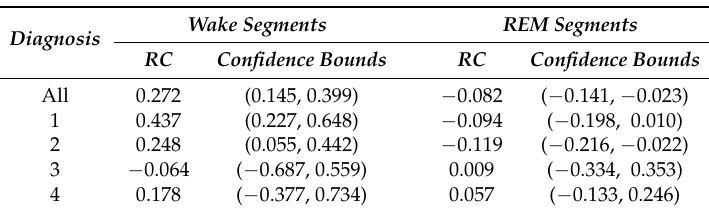
Table 5. The summary of regression coefficients (RC) of the age dependence of Wake and REM sleep stages with their 95% confidence bounds.